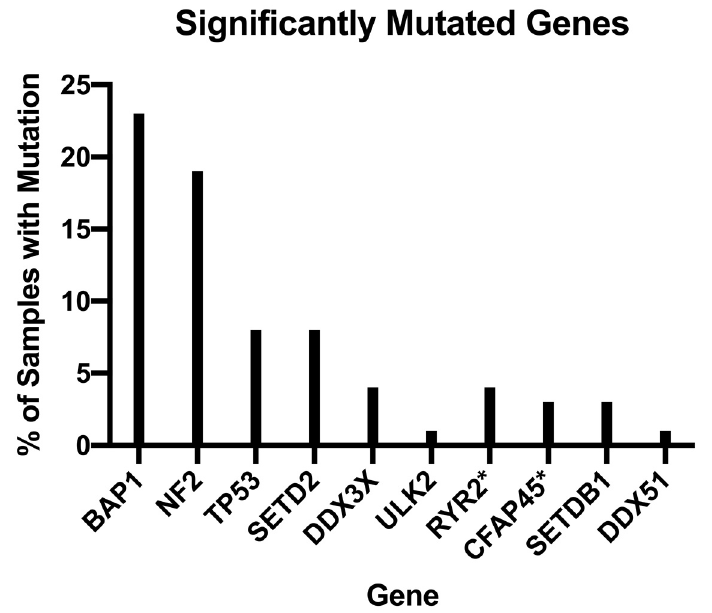
Figure 2. Bar graph depicting the proportion of samples studied by Bueno et al. found to have significant mutations in the corresponding gene ( n = 202, * N = 99). Table 1. Pooled specificity and sensitivity values of biomarkers.